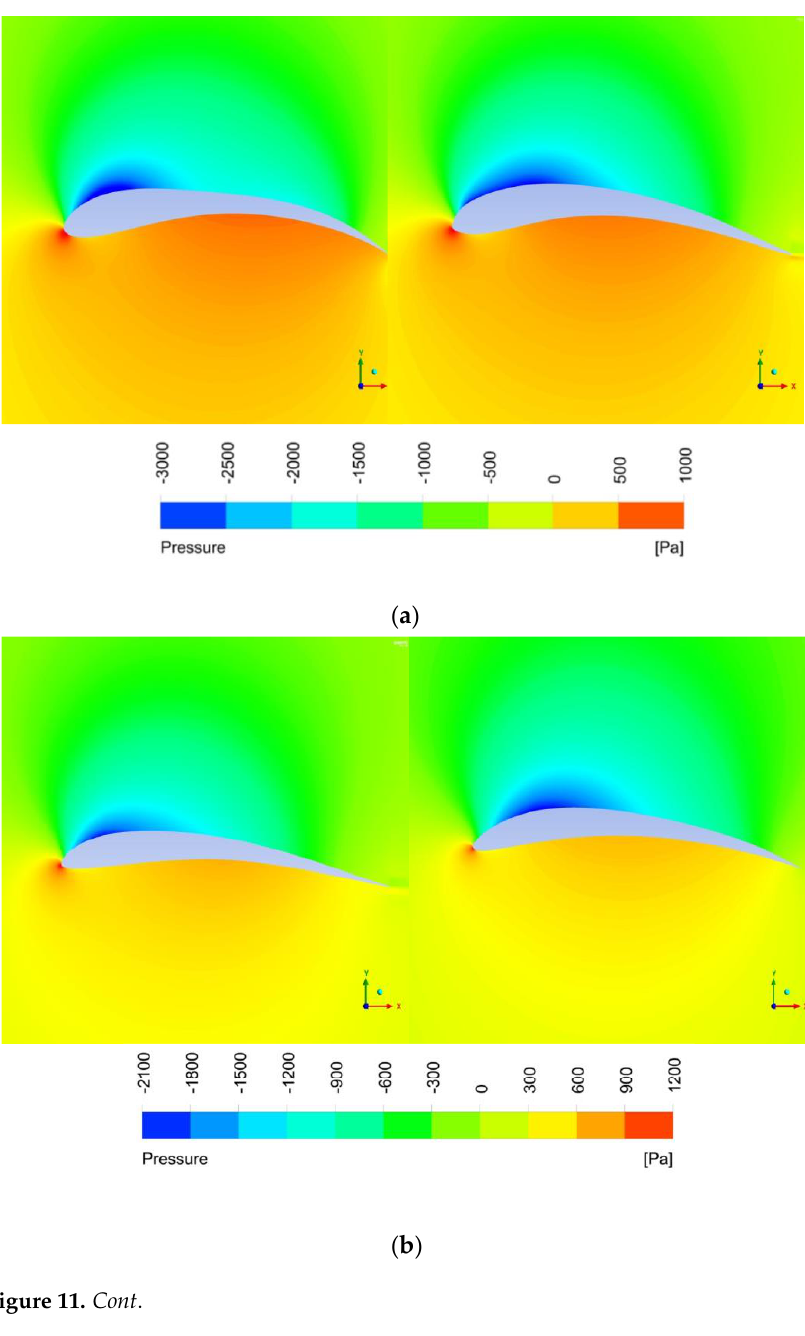
Table 4 lists the maximum lift coefficients of the three bionic airfoils at an angle of attack of 15 ◦ . The initial airfoil with the smallest lift coefficient at the angle of attack 15 ◦ was the sparrowhawk airfoil, and the one with the largest lift coefficient was the long-eared owl airfoil. After optimization, the long-eared owl wing type had the largest lift coefficient. However, based on the comparison of the lifting ratios, the seagull airfoil had the best optimization effect (7.86%) under the same optimization objective and constraints. The long-eared owl airfoil had the worst optimized maximum lift coefficient of 3.4%.